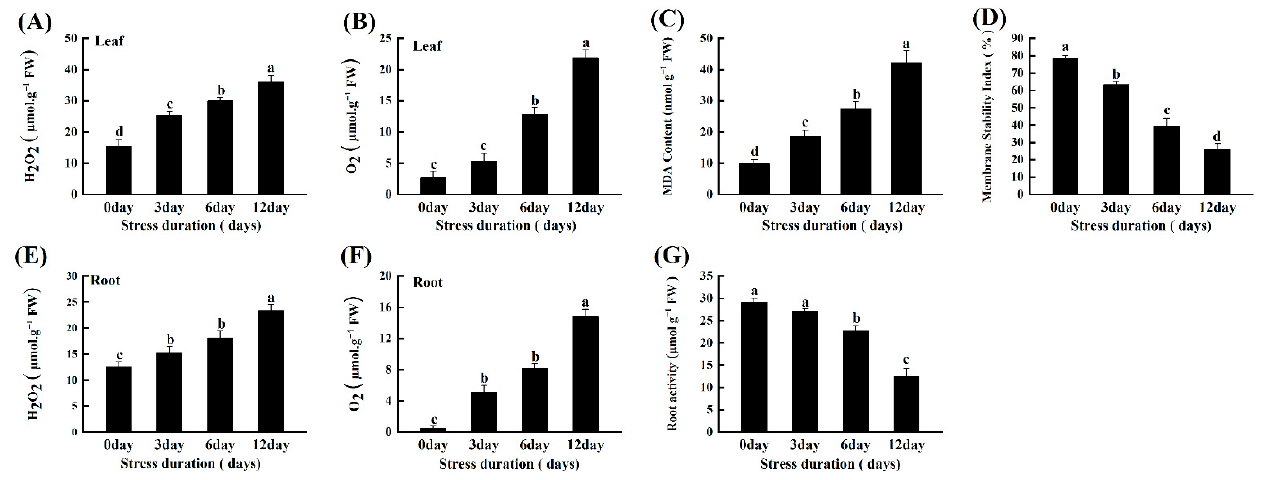
Figure 4. Effects of salt stress on H 2 O 2 in leaves; roots ( A , E ); O 2• − in leaves; roots ( B , F ); malondialdehyde (MDA) ( C ); membrane stability index MSI ( D ); and root activity ( G ) of tomato seedlings grown for 12 days under control and salt stress. Values are mean ± SD (Standard Deviation) of three replications. Different letters indicate significant differences at p ≤ 0.05 (Tukey’s HSD test).